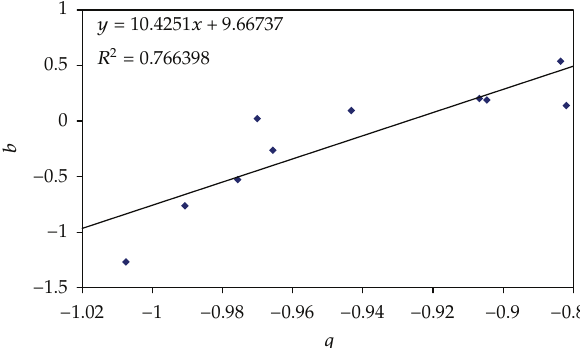
Figure 8: Parameter b values versus parameter q values, for all